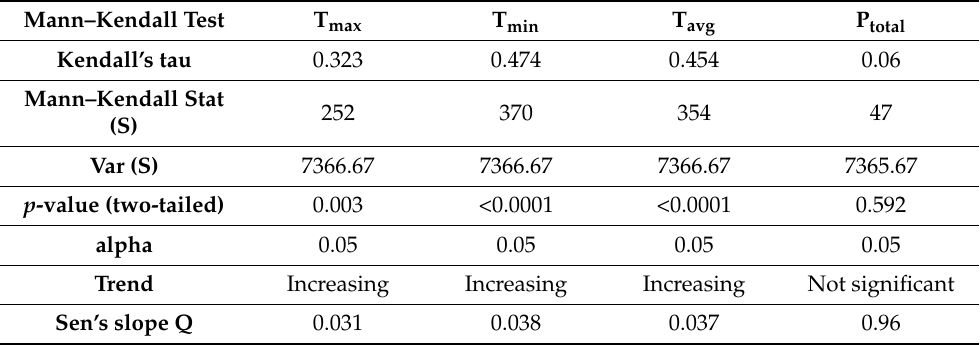
Table 1. Trend analysis of climate variables (T max , T min , T avg , P total ) using the Mann–Kendall test at the studied 26 wild blueberry fields of Downeast, Maine from 1980 to